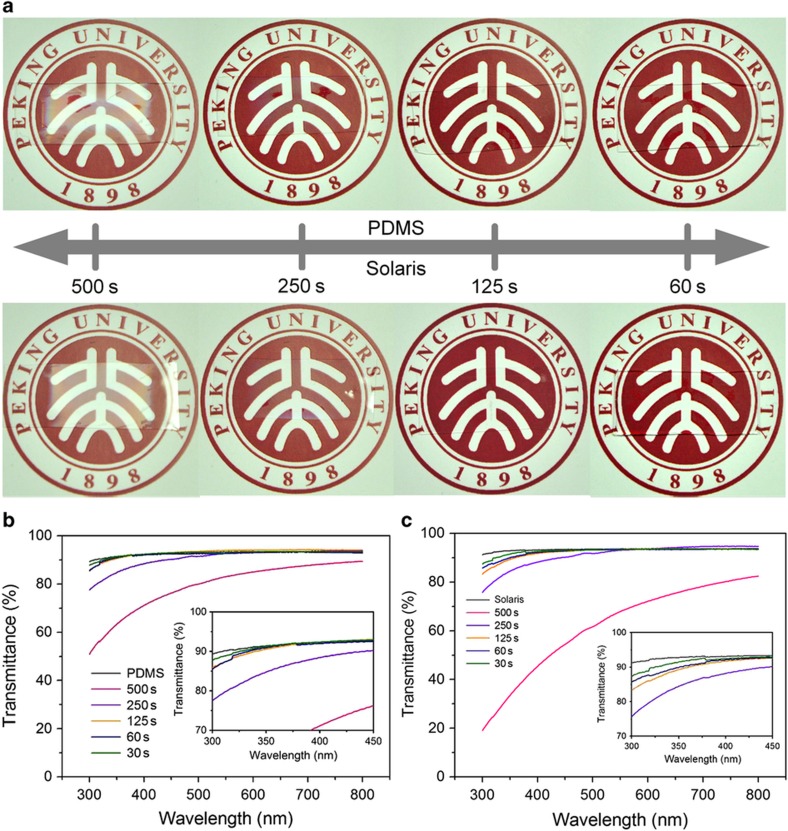
(a) The photographs of the wrinkle-patterned PDMS and Solaris membranes with different plasma-treating times to exhibit their high transparency. (b) The UV–vis spectrums of the wrinkle-patterned PDMS membranes with different plasma-treating times. (c) The UV–vis spectrums of the wrinkle-patterned Solaris samples with different plasma-treating times. UV–vis, ultraviolet–visible.